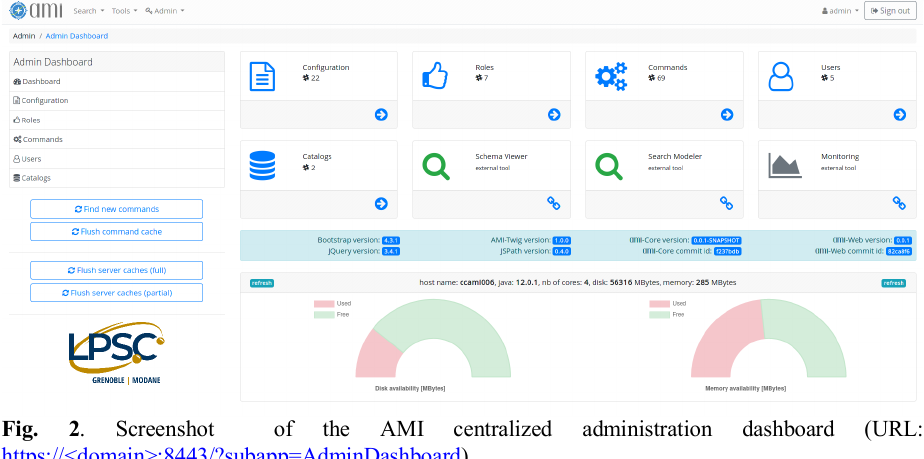
2 . Screenshot of the AMI centralized administration dashboard (URL: